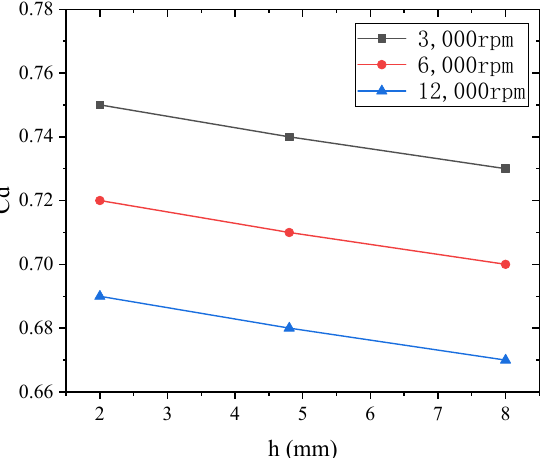
Figure 9. Tooth height–leakage characteristic curve at different rotating speeds.